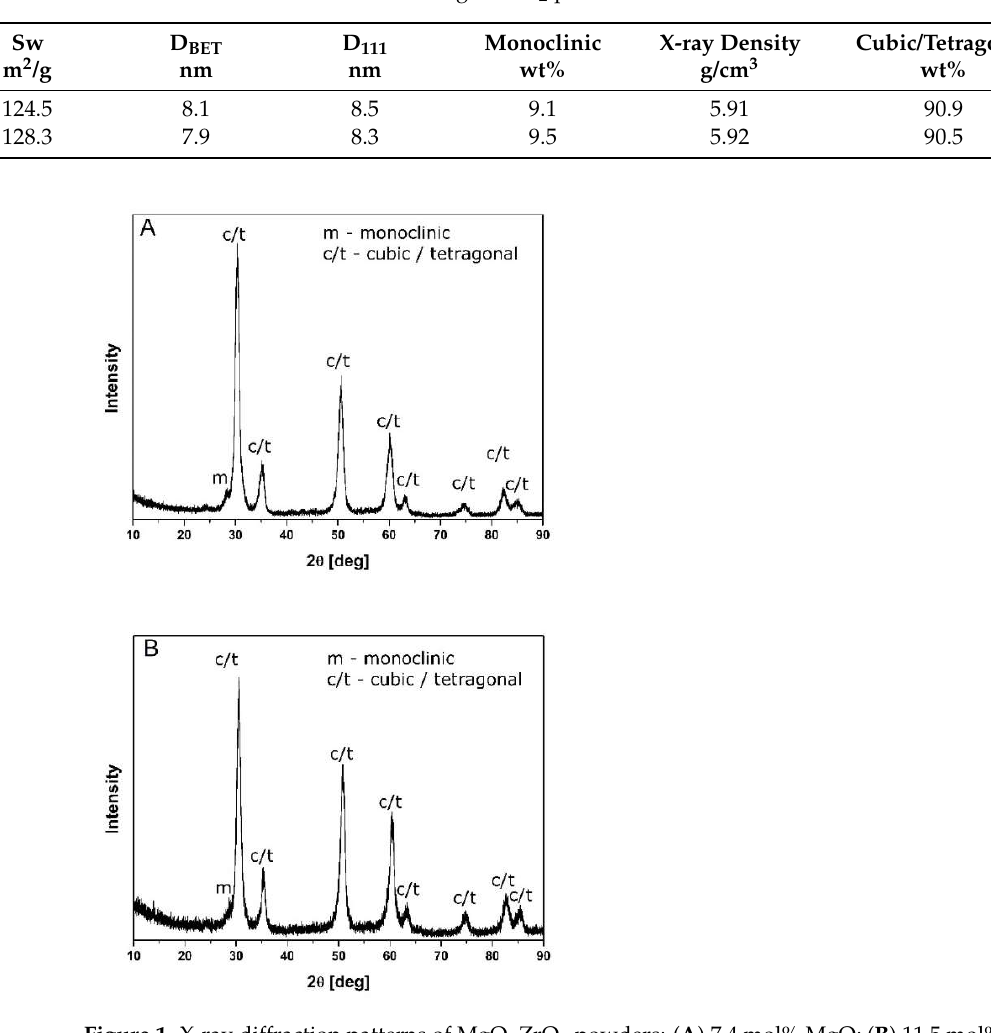
Figure 1. X-ray diffraction patterns of MgO–ZrO 2 powders: ( A ) 7.4 mol% MgO; ( B ) 11.5 mol% MgO.